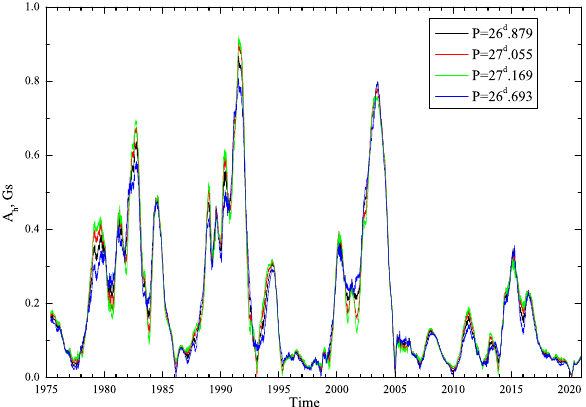
Figure 3. Time variation of the harmonic amplitude of oscillations for the periods indicated in Figure 2.